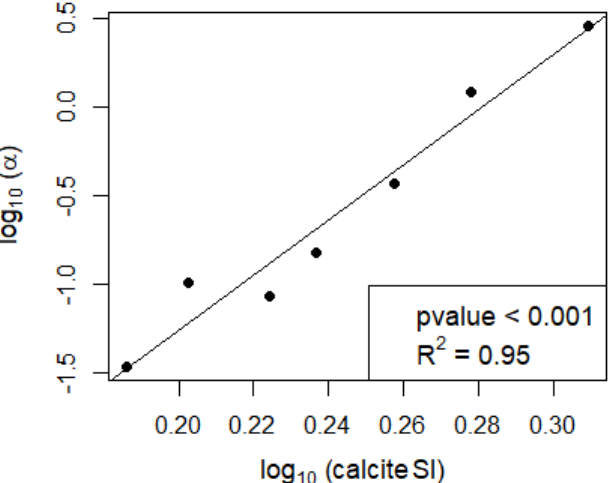
Figure 3. Relationship between the calcification to NEP ratio ( α ) and the calcite SI (note the log–log scale).